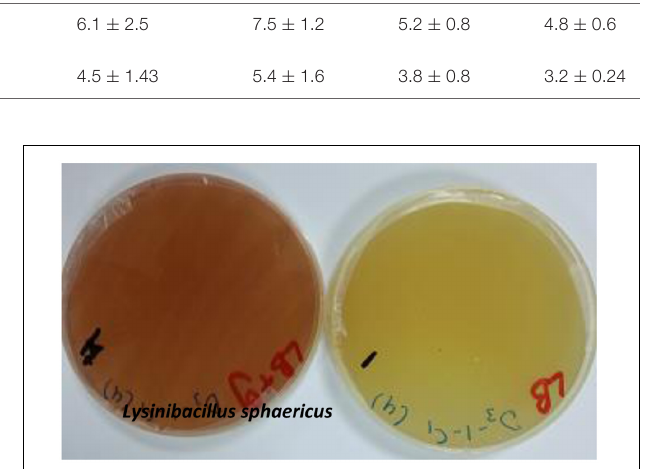
FIGURE 2 | HCN production by L. sphaericus ZA9 on Luria Bertani agar medium amended with glycine.